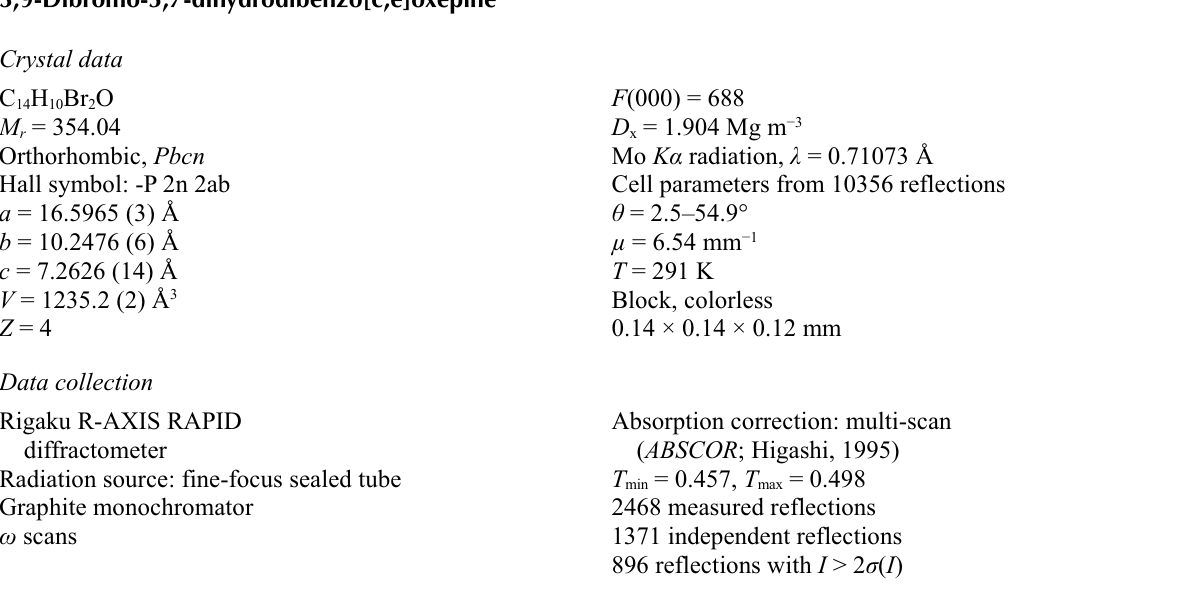
The synthesis route for the preparation of